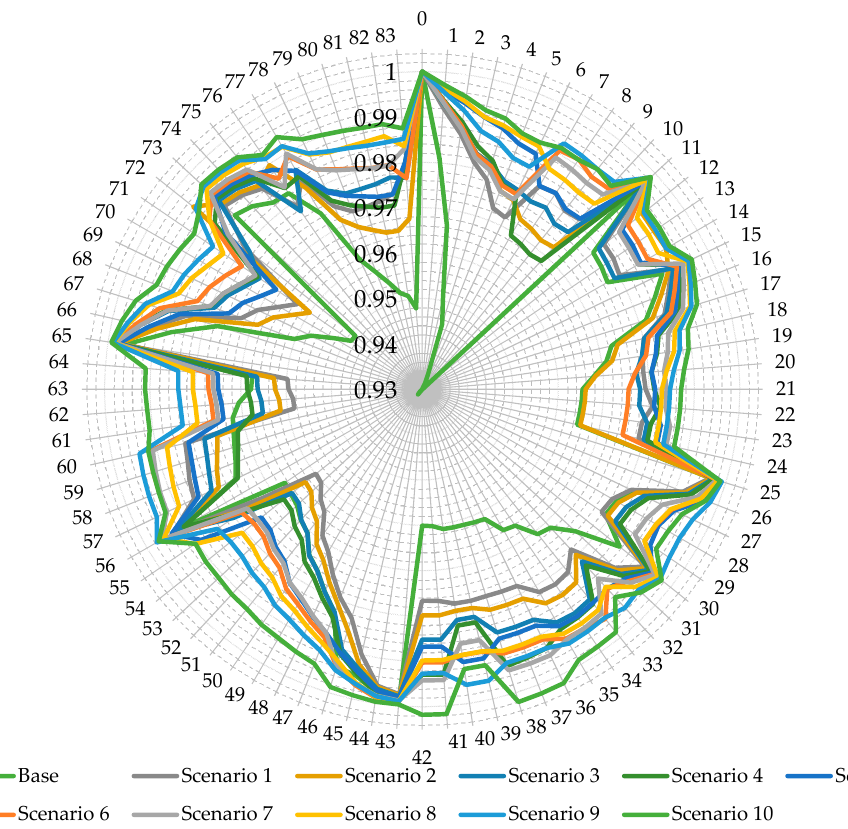
Figure 14. Voltage profile for the 83-node system for di ff erent